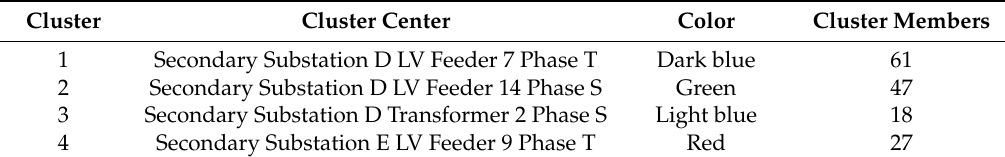
Figure 10. ( a ) Number of clients in relation to the number of points of delivery and ( b ) in relation to the contracted power in the case study. Table 3. Composition of the